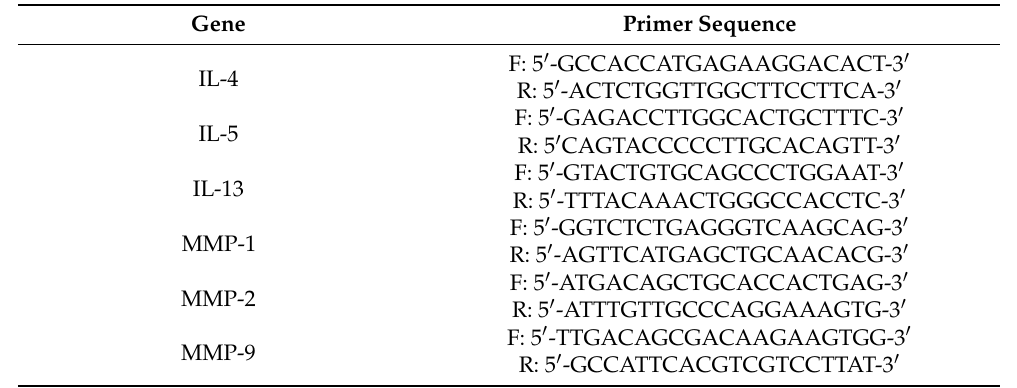
Table 4. Specific primer